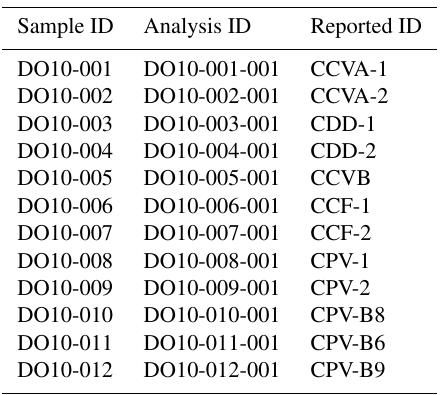
Table 2. Example to show how samples are coded in the WALIS